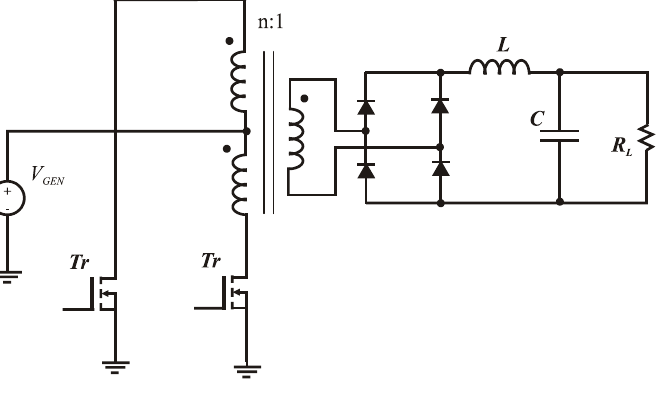
Figure 1. Push–pull converter.